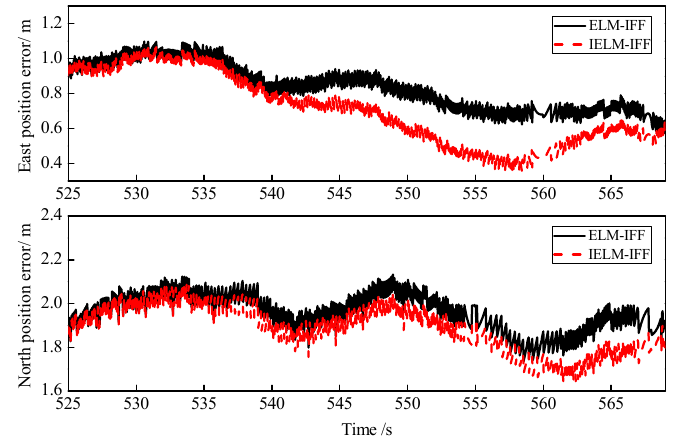
Figure 16. Curves of position errors for ELM-IFF and IELM-IFF in the case of good GPS signal.